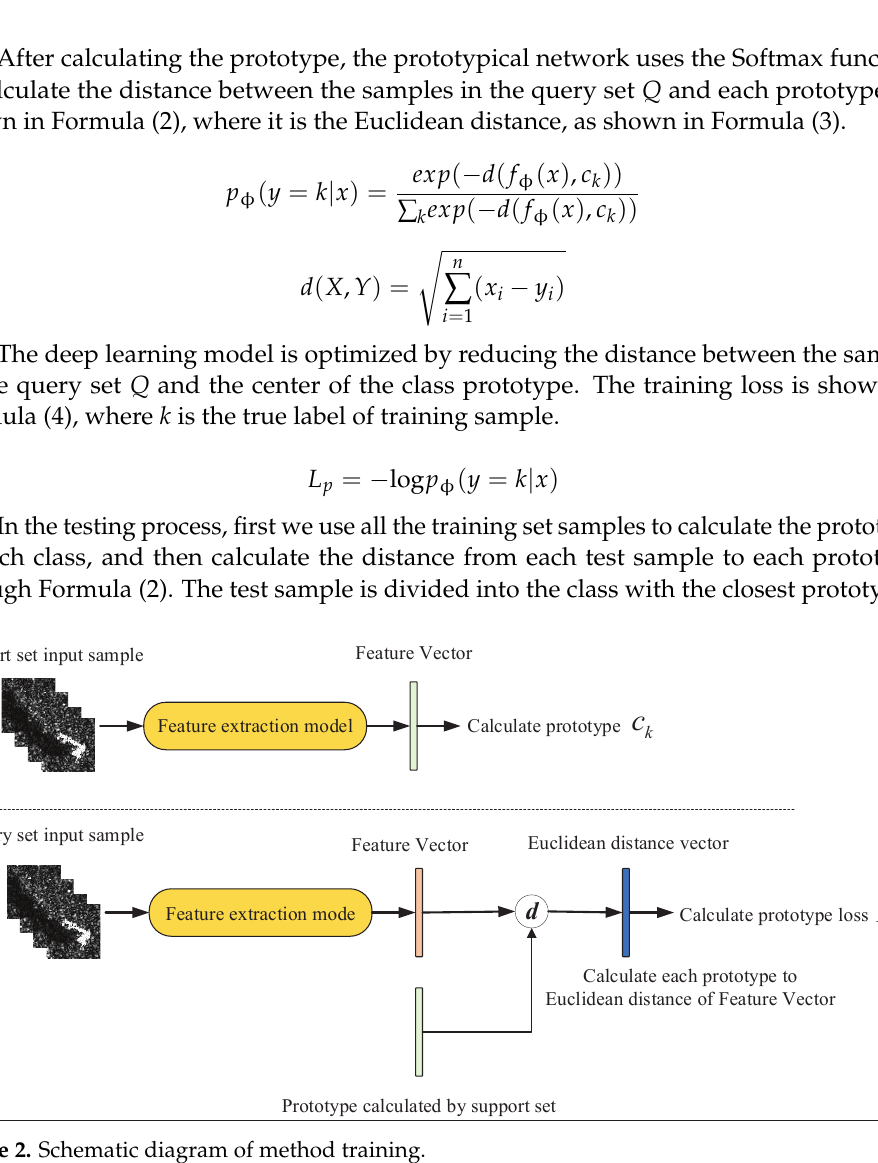
Figure 2. Schematic diagram of method training.